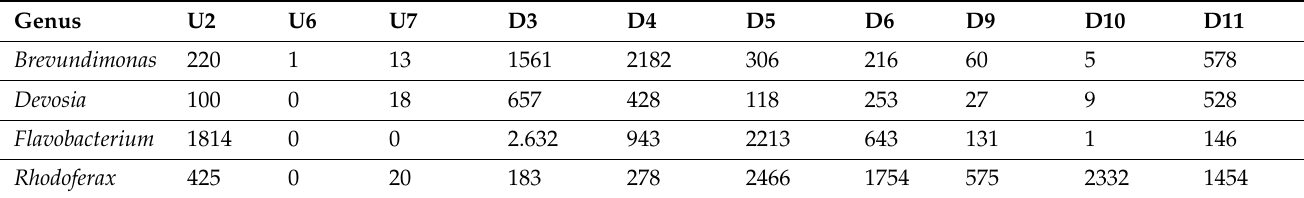
Table 9. Greatest bacterial abundance by genus across all the sites.